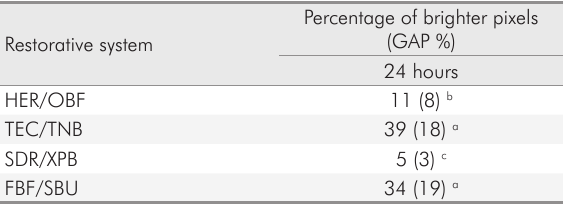
Table 3. Mean brightness values (%) at the interfacial zone between dentin and restorative